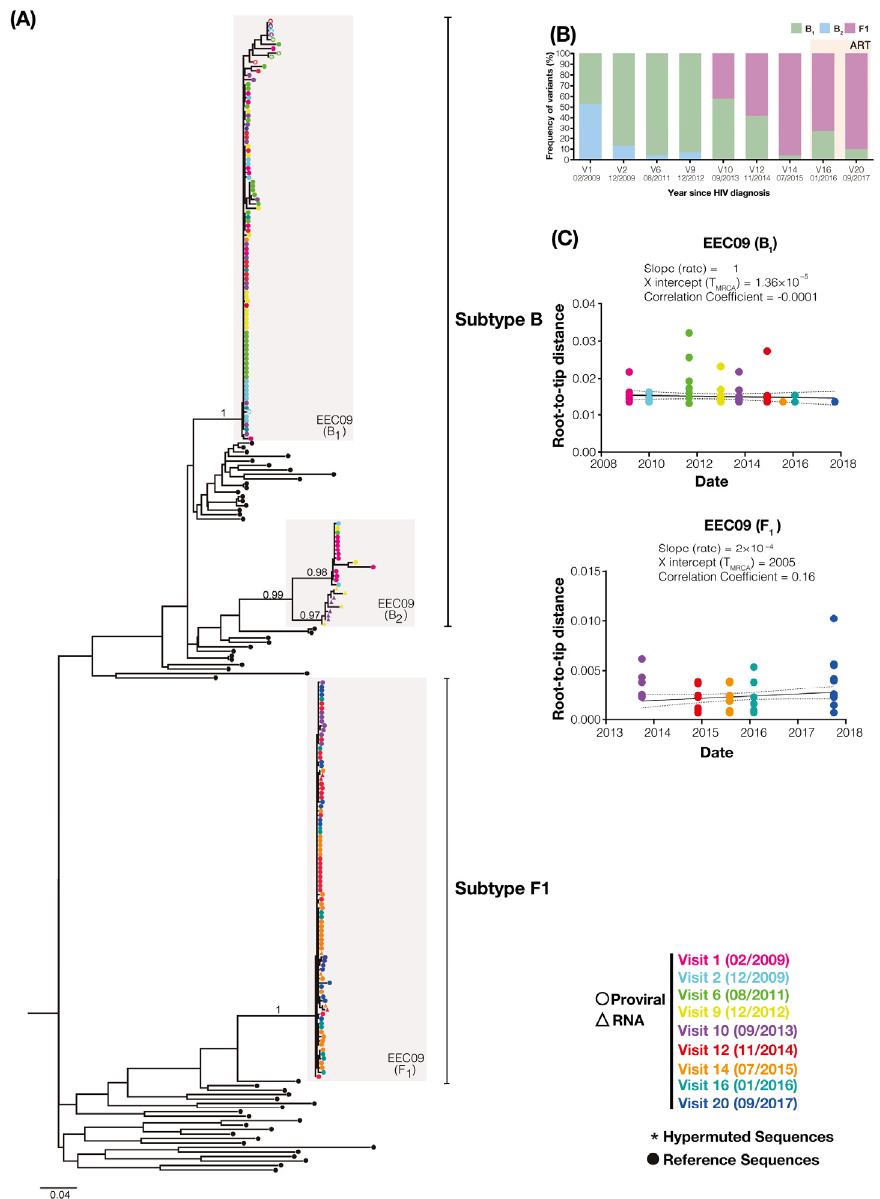
Figure 2. HIV-1 env gene sequences detected during follow-up of subject EEC09. ( A ) Longitudinal analysis of HIV-1 PBMC-associated DNA (circles) and plasma RNA (triangle) env sequences obtained from individual EEC09 between 2009 and 2017. Circles in the tips of the ML phylogenetic tree are colored according to the visit analyzed as shown in the legend at the bottom right. The gray shaded boxes highlight monophyletic clusters corresponding to each viral variant. White asterisks inside the circles highlight the sequences with APOBEC3G/F-mediated G to A hypermutations. Black circles point to the reference sequences, and vertical lines indicate subtype-specific clades (B and F1). Horizontal branch lengths are proportional to the bar at the bottom indicating nucleotide substitutions per site. The aLRT support is shown for key nodes. ( B ) The percentage of each viral variant at the PBMC compartment over time (years) is shown on the left Y-axis. ( C ) The plot of the root-to-tip distance against sequence sampling time of each viral variant. The colors of the circles represent the sampling time of DNA viral sequences according to the legend at the bottom right.